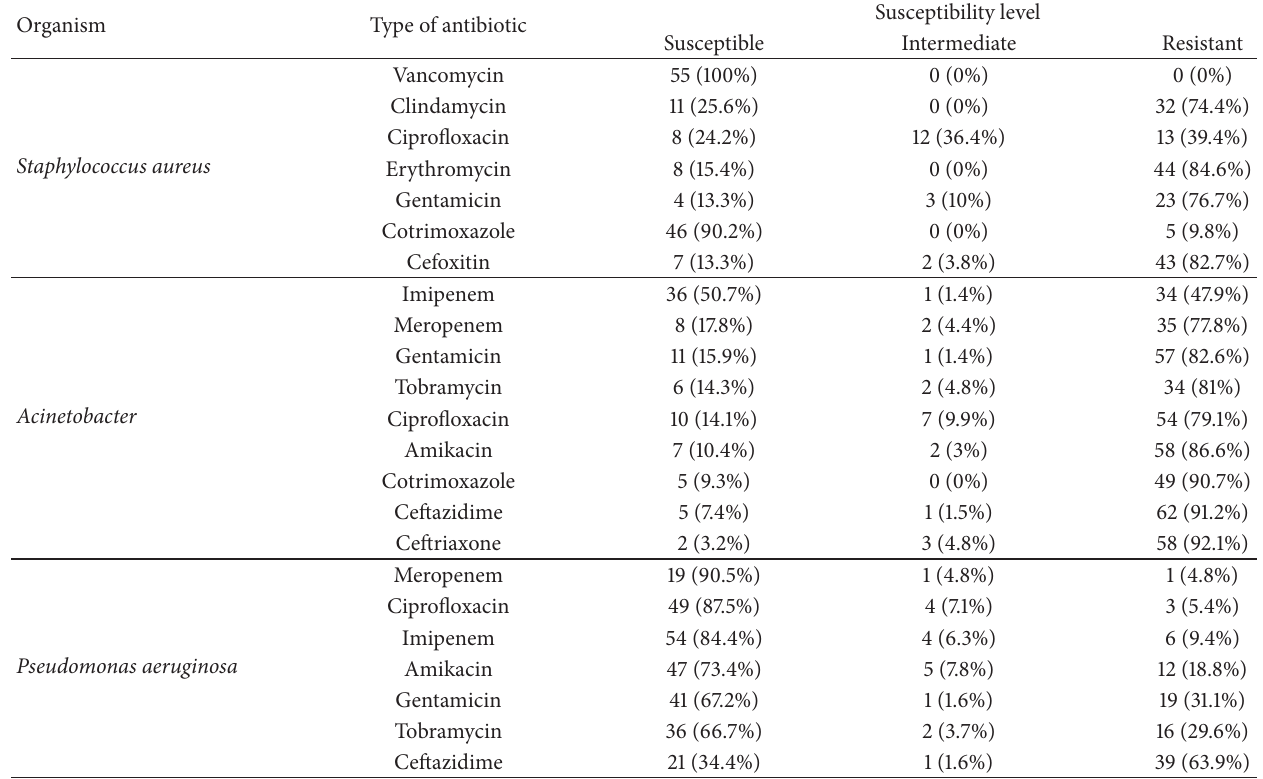
Table 5: Antimicrobial susceptibility pattern of isolated organisms from sputum.